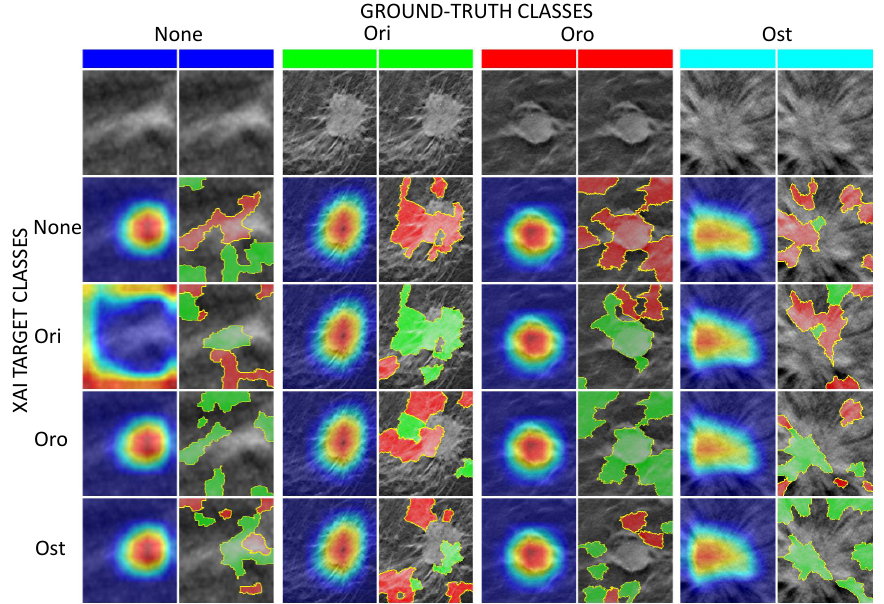
Figure 14. Grad-CAM and LIME comparison. One sample image is used for every class; then, the re- sults of the XAI perceptive method are shown, considering each of the four possible target